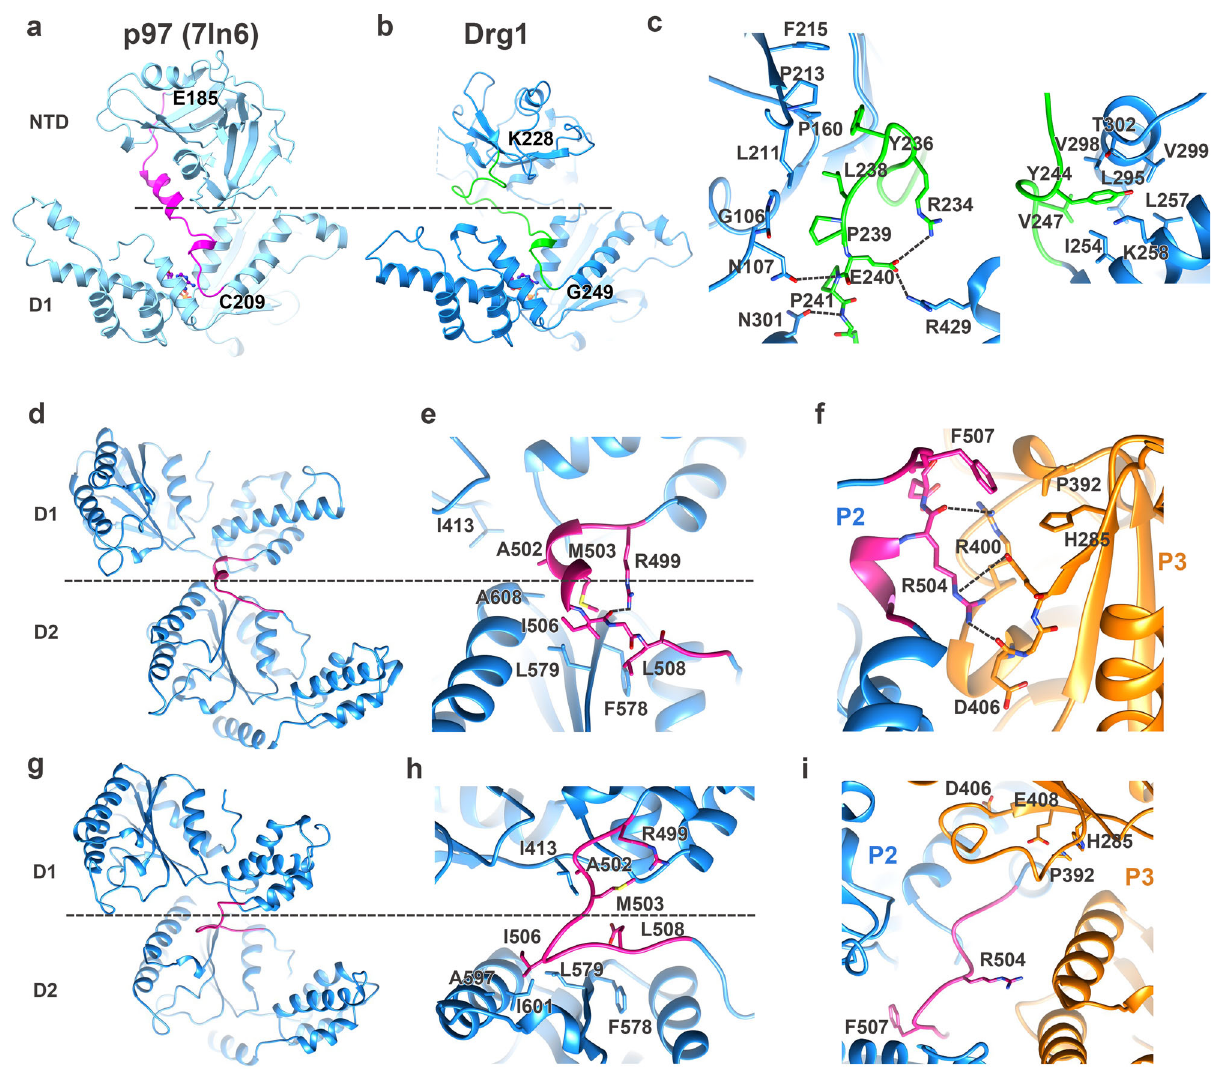
Fig. 8 | Structural comparison of the NTD-D1 and D1-D2 linker in the Drg1 hexamers.a , b StructuralcomparisonoftheNTD-D1linkerinthestructuresofp97 ( a ) and Drg1 ( b ). c Interaction details of the NTD-D1 linker in the structure of Drg1 hexamer. d – f StructureoftheD1-D2linkerinthesubstrate-engaged(translocating)